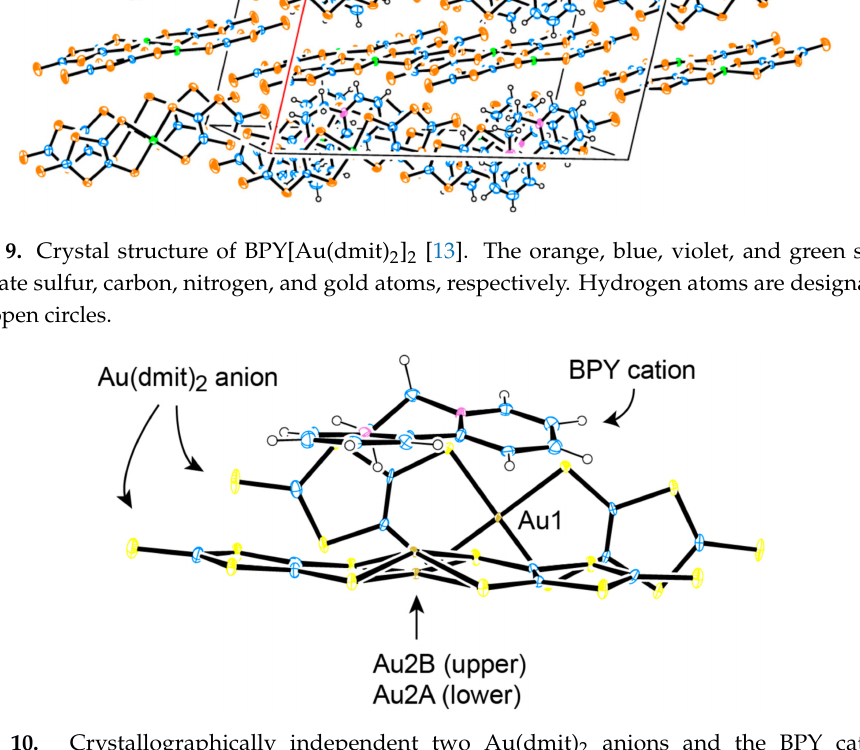
Figure 10. Crystallographically independent two Au(dmit) 2 anions and the BPY cation in BPY[Au(dmit) 2 ] 2 [13]. The yellow, blue, and light brown spheres designate sulfur, carbon, and gold atoms, respectively. Hydrogen atoms are designated black open circles.